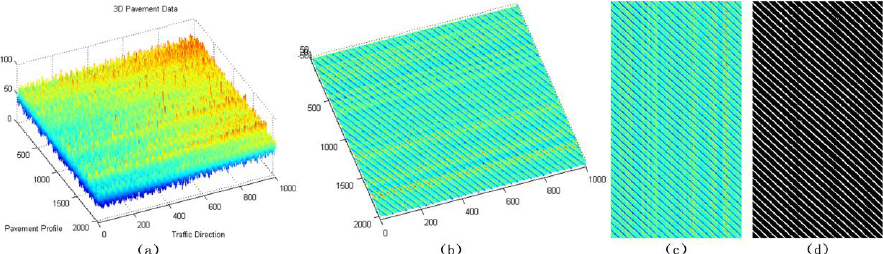
Figure 18. The 3D airport asphalt pavement Data 1 and corresponding sparse components, ( a ) 3D data from airport asphalt pavement; ( b , c ) corresponding sparse components; ( d ) pavement groove information extracted from sparse